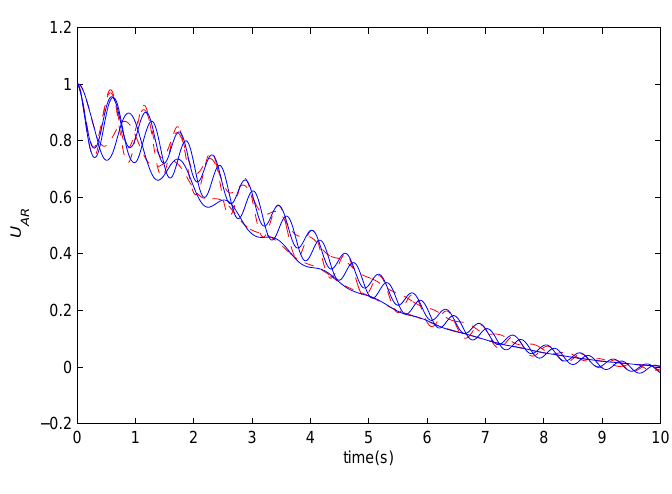
Figure 11. The regional demand U AR